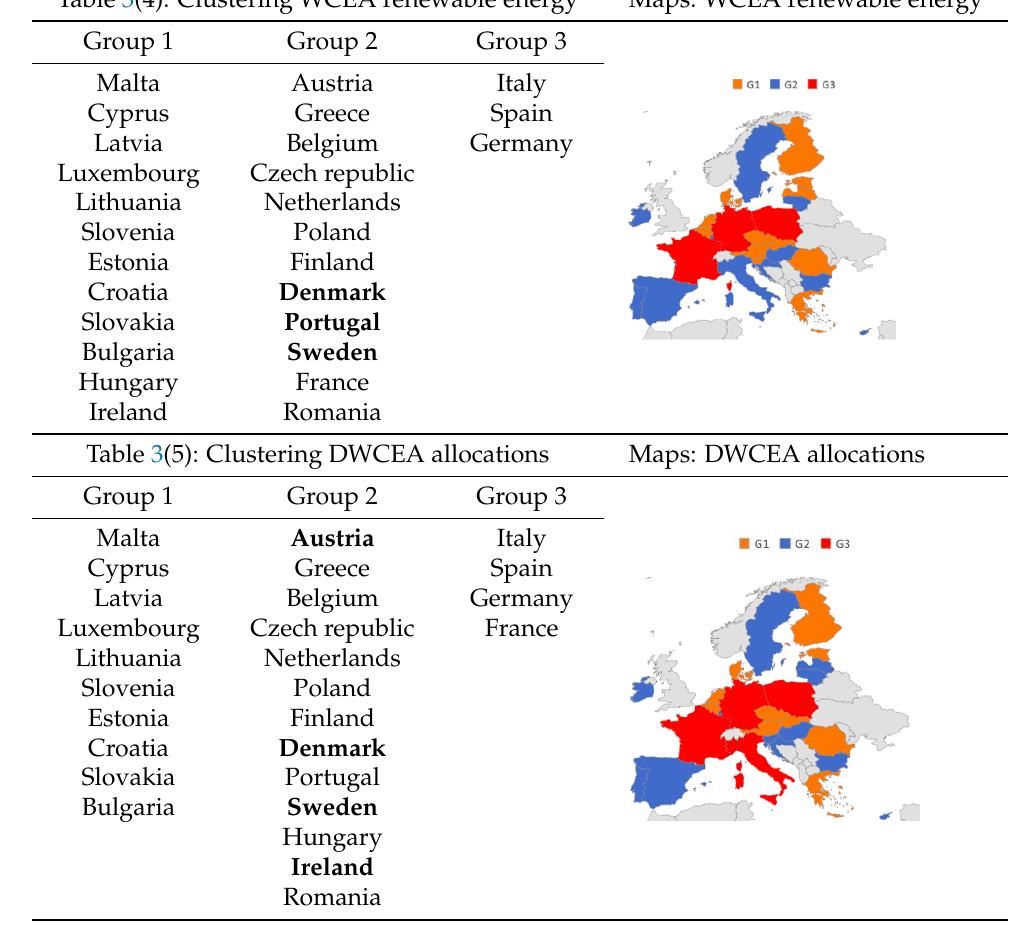
Table 3. Cont. Table 3(4): Clustering WCEA renewable energy Maps: WCEA renewable energy Group 1